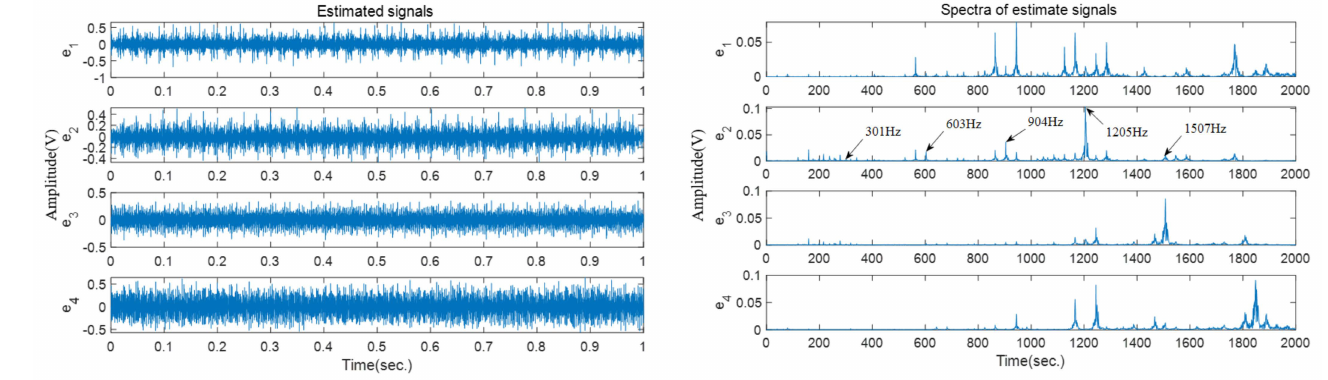
Figure 13. Time − domain waveforms and frequency spectra of the four recovered